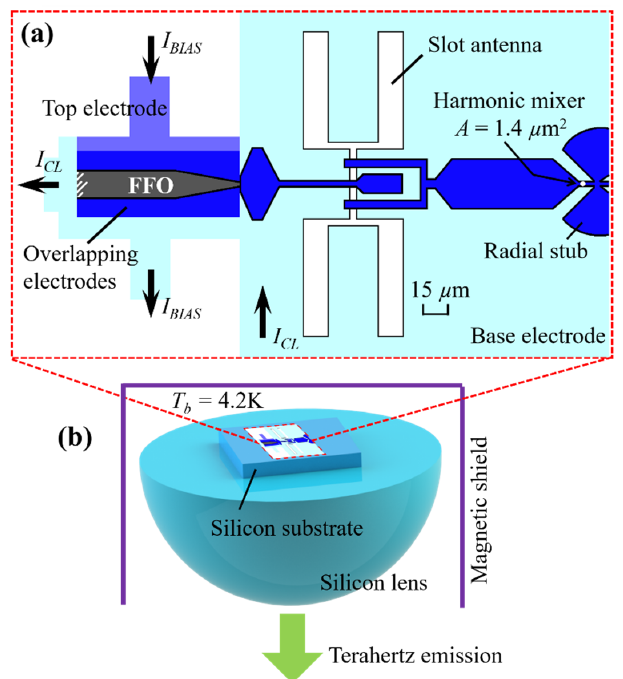
Figure 1. ( a ) Layout of the Nb/AlO x /Nb-based integrated microcircuit containing the FFO, the double slot antenna, the harmonic mixer (HM) and the Nb/SiO 2 /Nb-based transmission lines; ( b ) Sketch of emitter microcircuit mounted on a hemispherical silicon lens, transferring the THz emission to open space.